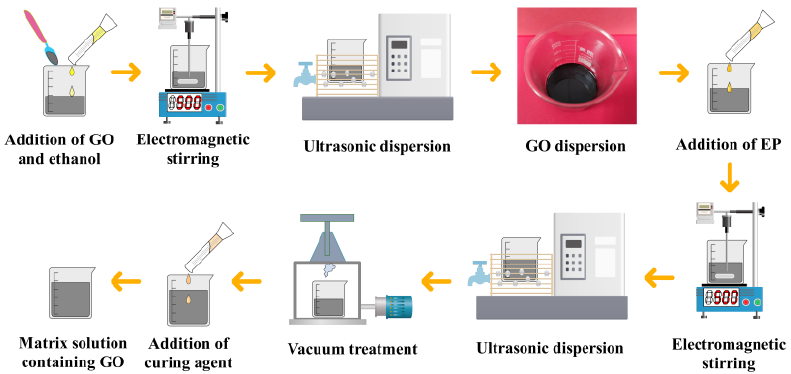
Figure 2. Preparation of curing mixed solution.